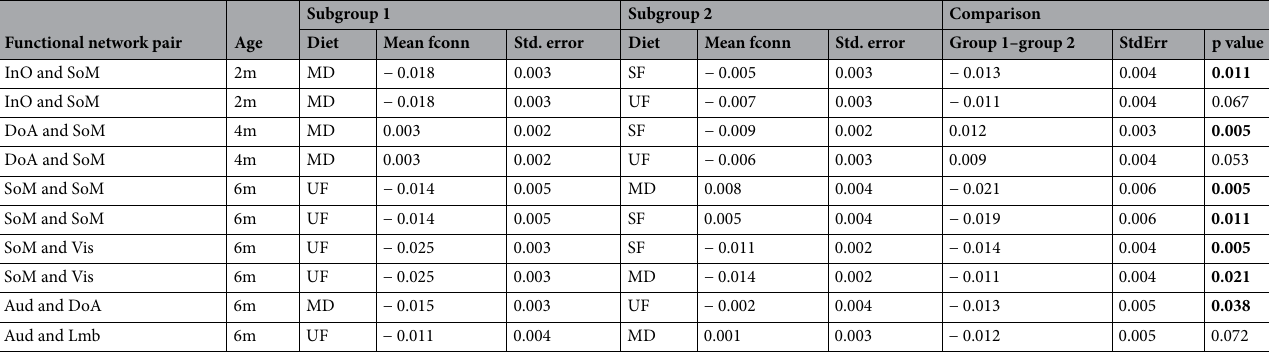
Table 3. Post-hoc analysis for the 3-way interaction of diet, age and networks using functional connectivity. Each subgroup corresponds to the 3-way interaction of diet, age and networks shown in Fig. 2. Subgroups are sorted by age, then by functional network pair with the lowest p-value. Subgroup 1 has always the largest absolute value of functional connectivity compared to Subgroup 2. p-values < 0.05 highlighted in bold font. m, age in months; MD, mixed-fed; UF, un-supplemented formula; SF, supplemented formula. InO, Insular- Opercular network; SoM, Somatomotor network; DoA, Dorsal Attention network; Vis, Visual network; Aud, Auditory network; Lmb, Limbic